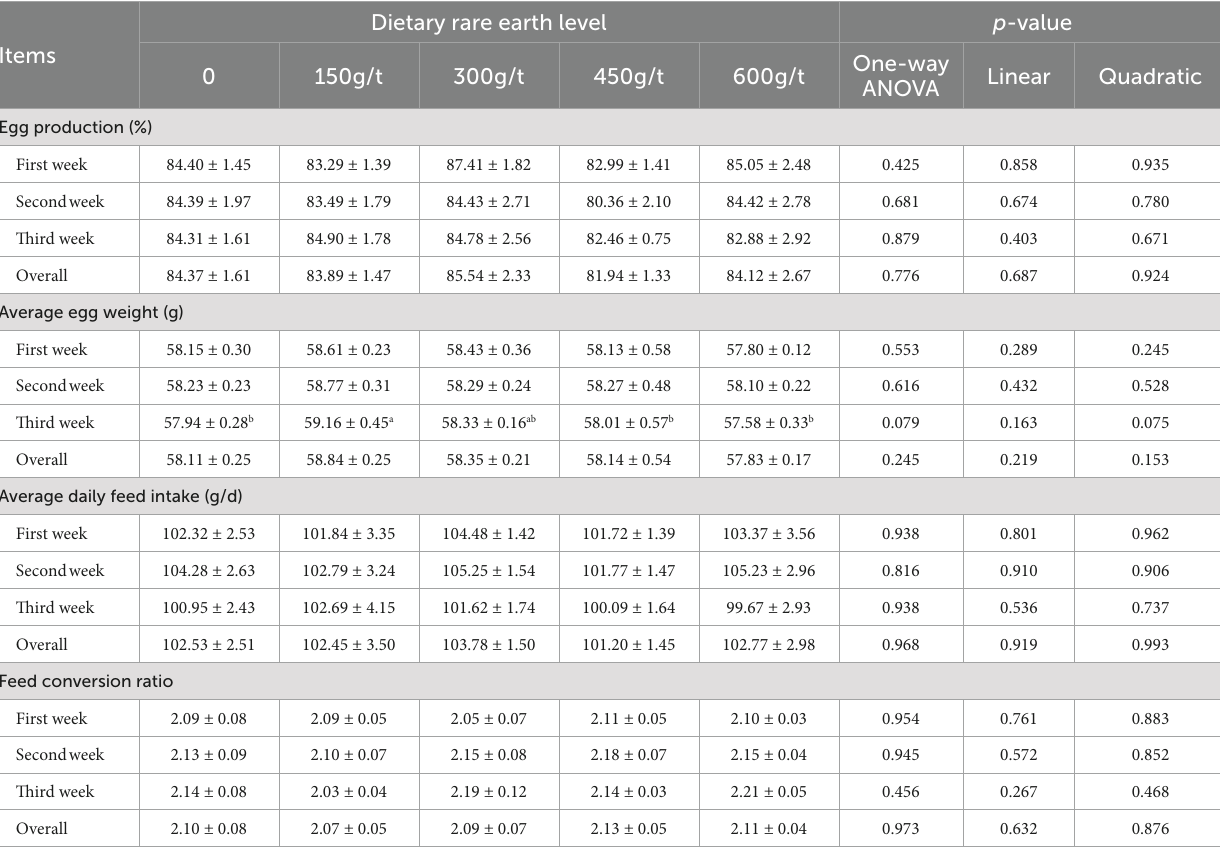
TABLE 2 Effects of dietary rare earth supplementation on production performance in laying hens during the late laying stage ( n = 6).